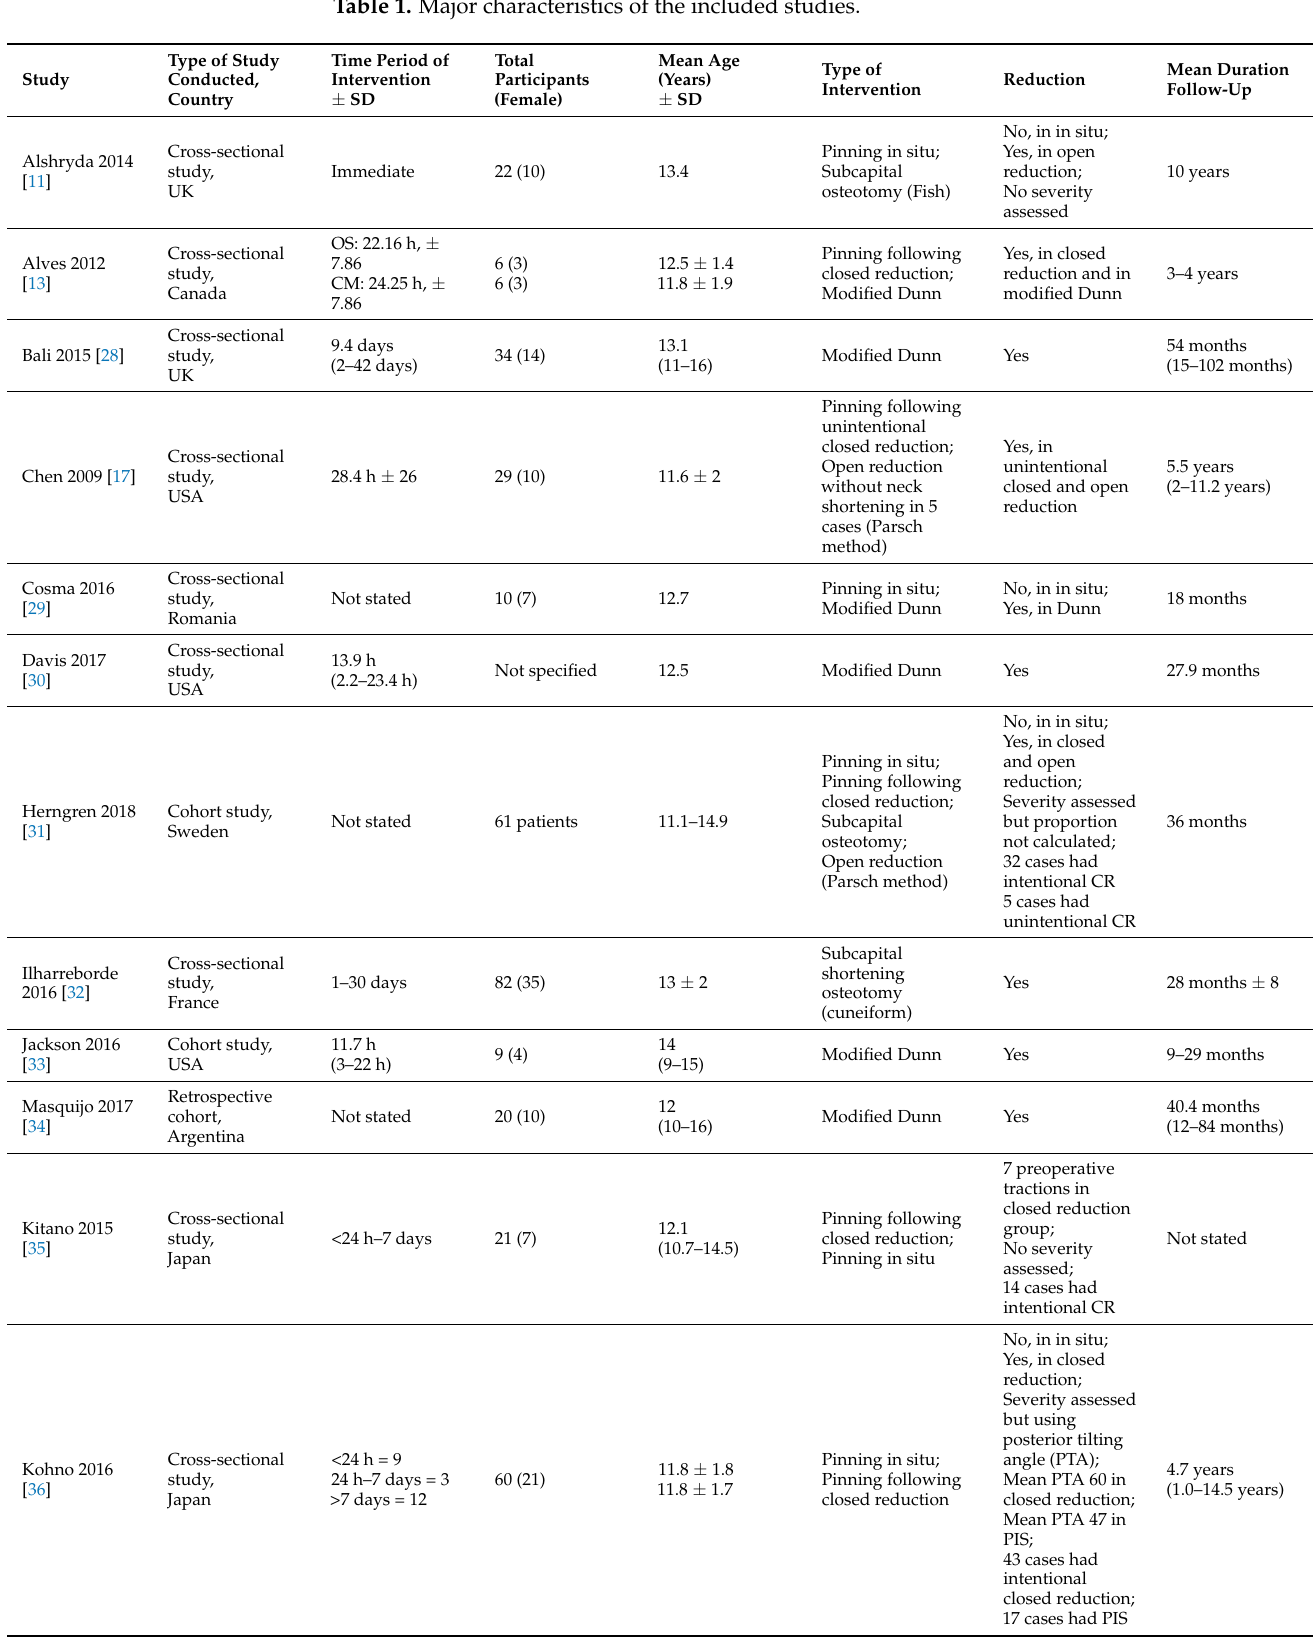
Table 1. Major characteristics of the included